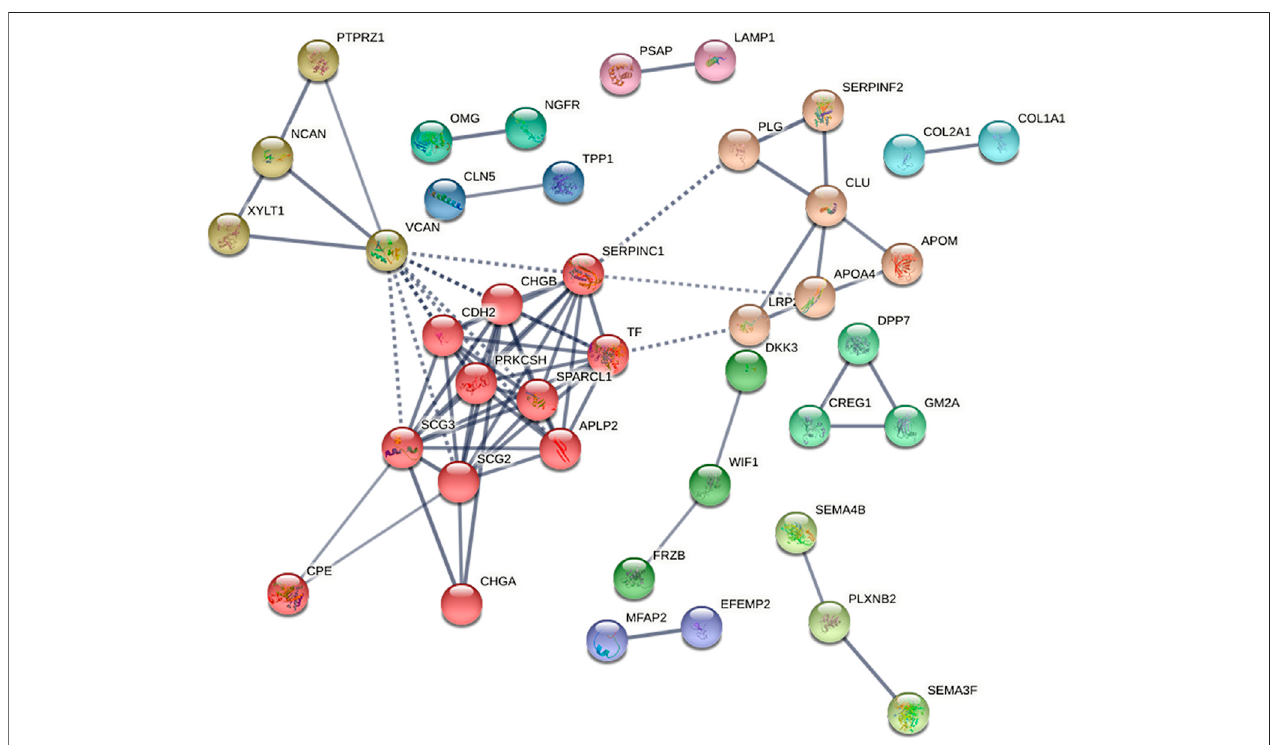
FIGURE 5 | The protein – protein interaction network for differentially expressed proteins in SO vs . ERM, predicted by STRING 11.0 set to high con fi dence (0.70), organism ( Homosapiens ),thatisbasedoninteraction evidence.Theprotein – proteininteractionnetworkwasgroupedinto11relevantprotein clustersusingtheMarkov Cluster Algorithm (in fl ation parameter, 3) clustering option provided by